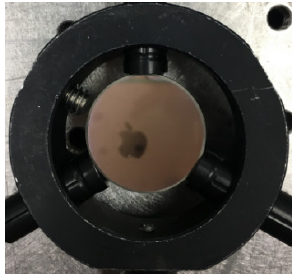
Figure 5. The plan mirror.